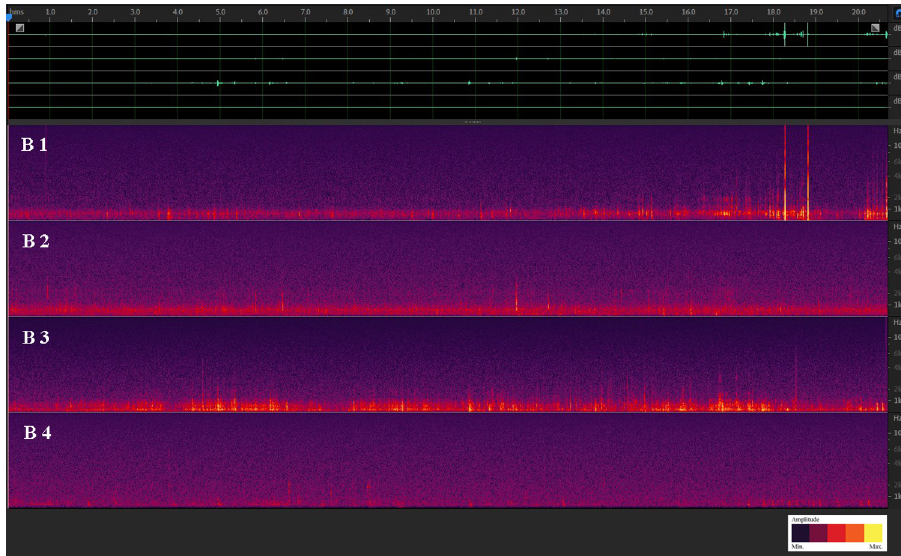
Fig 2. Spectrogram of a 4-channel recording from the Pfynwald soil (sensors B1–4, irrigated plot). Bright green waveforms on top: Display of the audio waveforms channels 1–4. Red/purple colored channels: Spectrograms channels 1–4, aligned from top to bottom. x axis: time, y axis: frequency. Channels 1–3 indicate sensor locations B1–B3 in Fig 1A). B4 is a control sensor in the air next to sensor B3. Channel 1 shows the movement sounds of a soil